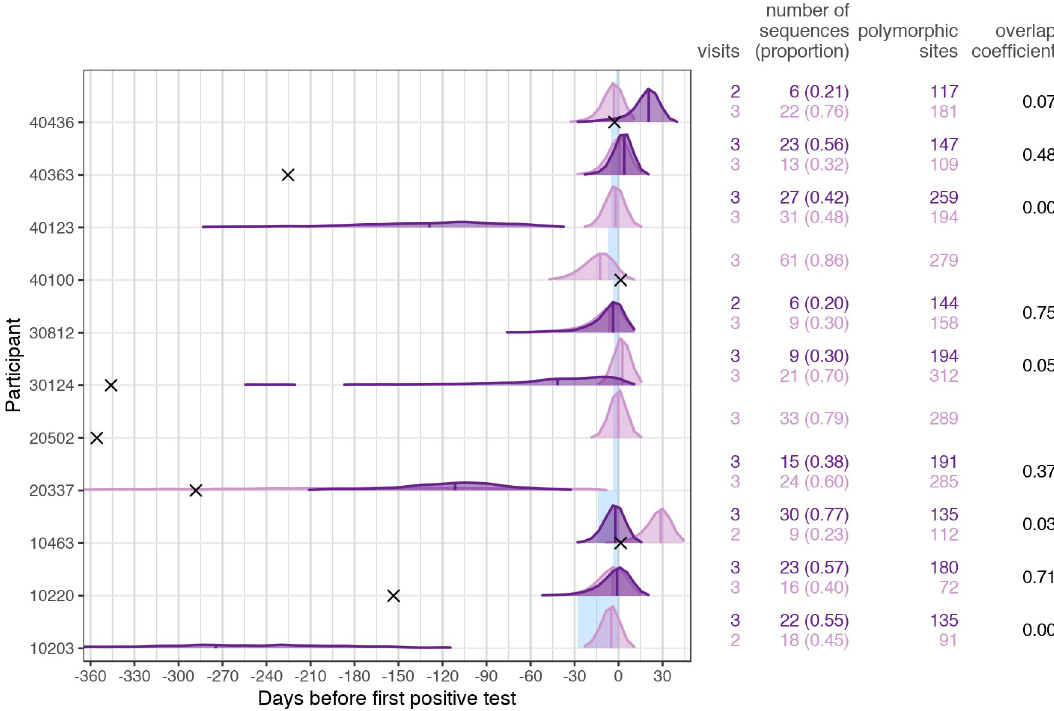
Fig 7. Improved BEAST estimates on the subpopulations from infections with multiple founder variants for the NFL genome. The posterior distributions for the best-fitting model for each identified founder population are shown, with vertical lines marking the median. The shaded blue area corresponds to the interval between the last negative and first positive HIV-1 RNA test (or diagnosis date). Black crosses show the median estimate from assuming a single population (crosses not shown for estimates beyond 365 days prior to diagnosis, which are figured in Fig 3B). The number of visits, sequences and polymorphic sites corresponding to each subpopulation are reported, along with the overlap coefficient for posterior distributions when two subpopulations were analyzed. Only subpopulations with sequences covering at least two time points, a minimum of five sequences with more than one informative site, and significant temporal signal were analyzed.